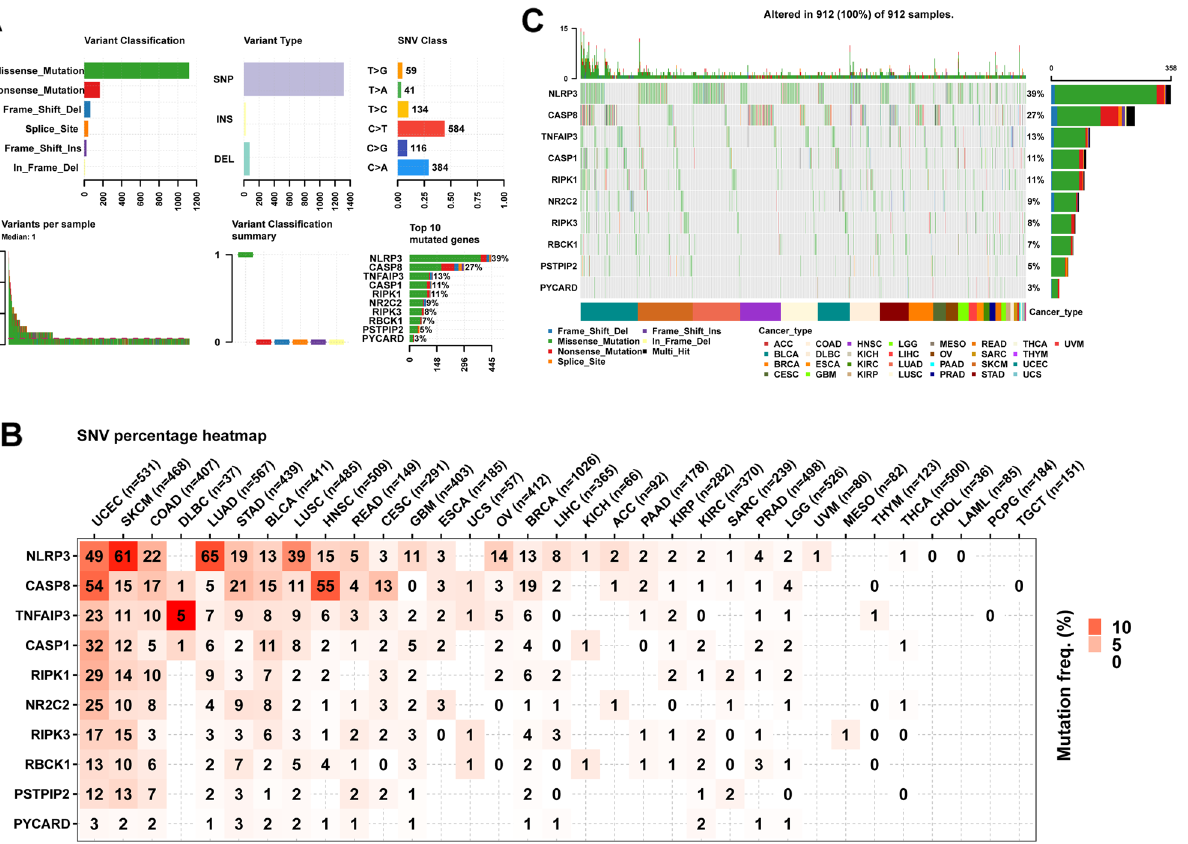
Figure 4. The SNV alteration of PANoptosis genes in pan-cancer. ( A ) The summary of SNV alteration. ( B ) SNV frequency of genes in indicated cancer types. ( C ) The waterfall plot shows the mutation distribution of 10 mutated genes across different